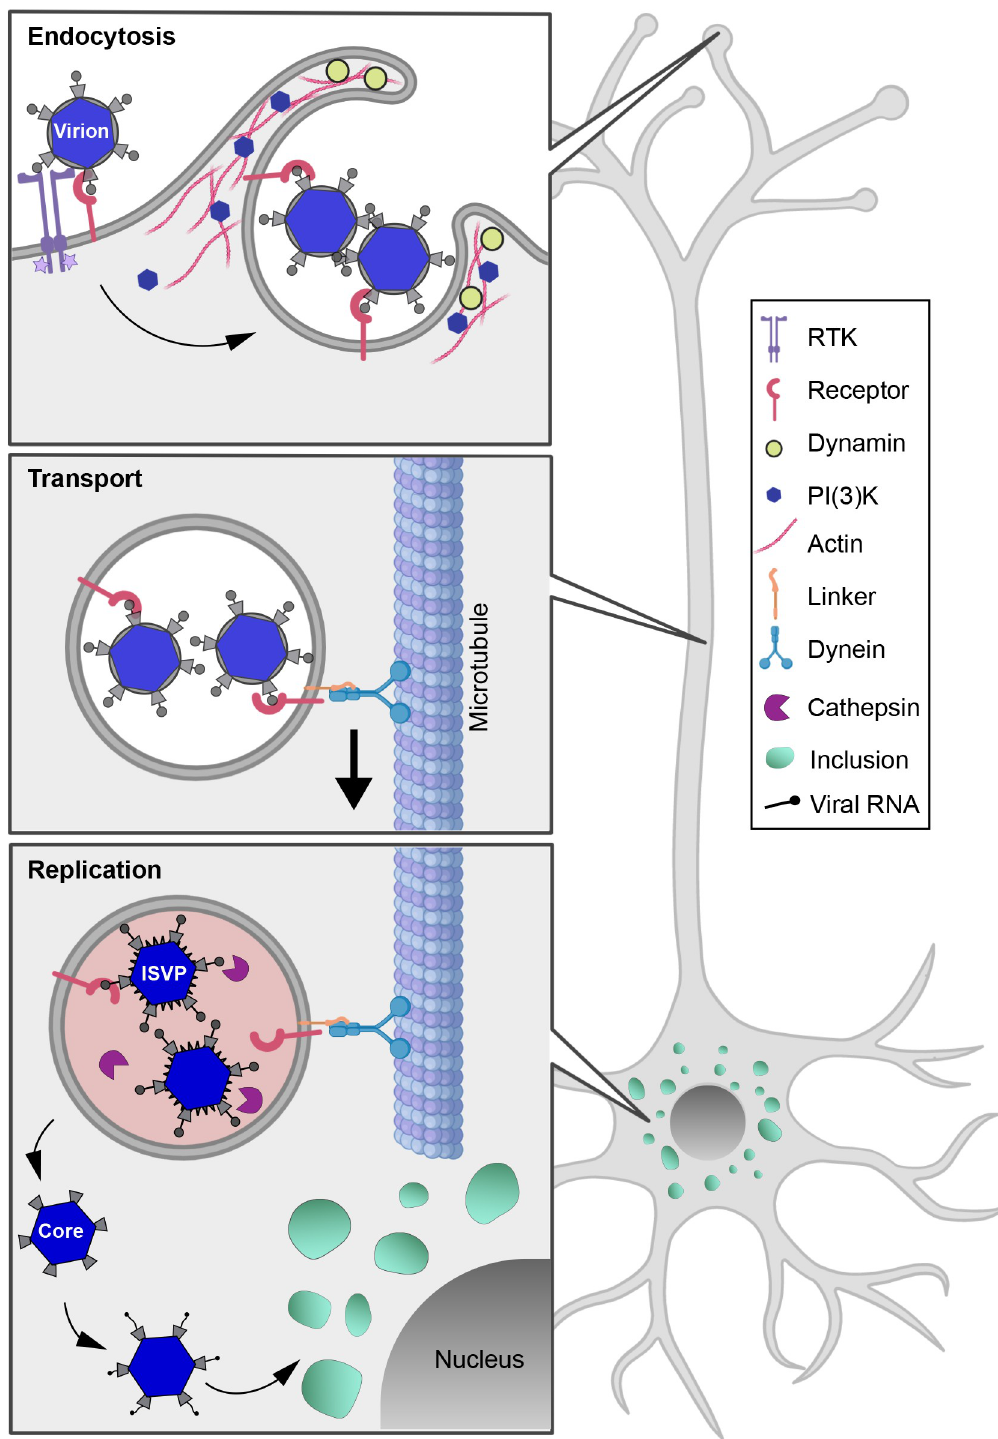
Fig 8. Schematic of reovirus entry and transport in neurons. Reovirus entry in neurons is mediated by macropinocytosis and requires actin, dynamin, PI(3)K, and receptor tyrosine kinase (RTK). Following entry, multiple intact virions are transported together in non-acidified vesicles by dynein motors along microtubule tracks in the retrograde direction. Vesicle acidification in the soma triggers proteolytic disassembly of virions, which enables release of cores into the cytoplasm. Transcription of viral RNAs from cores leads to the establishment of viral replication factories or inclusions.